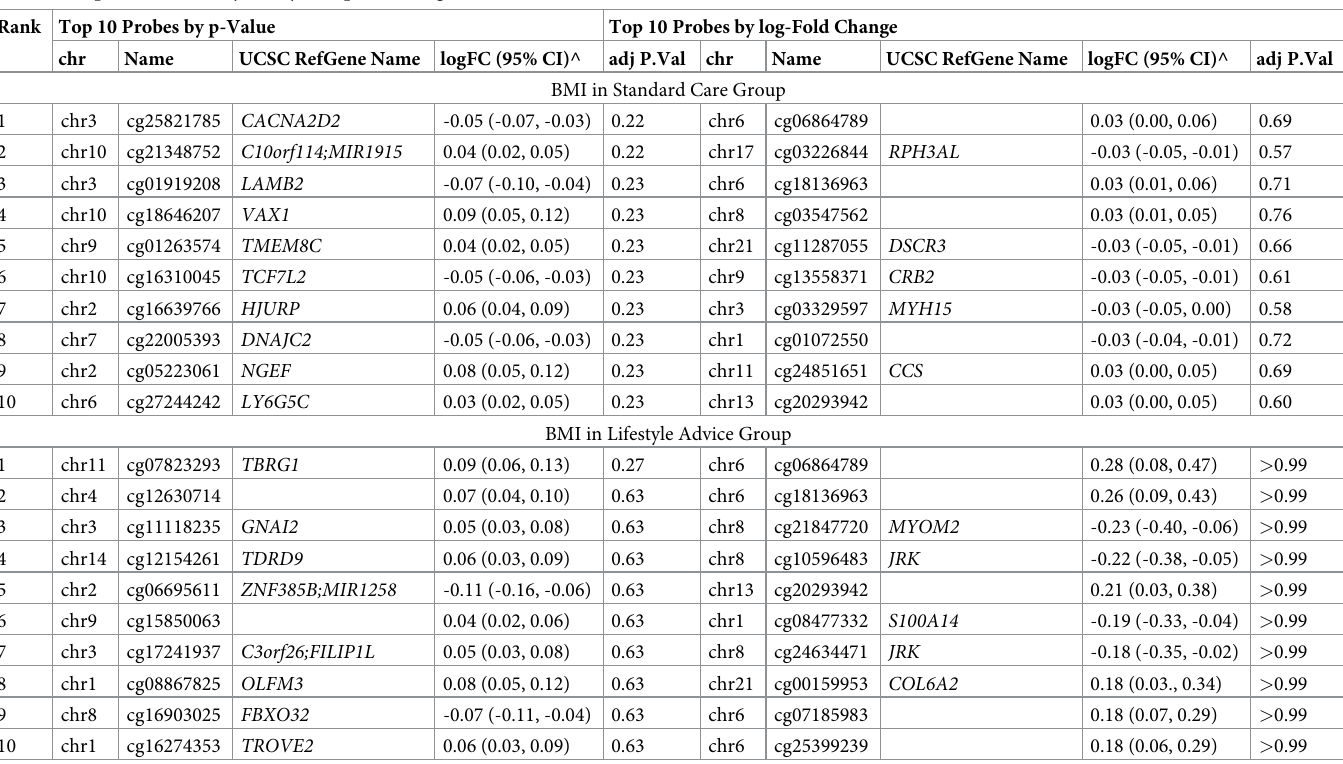
Table 3. Top 10 differentially methylated probes (5 kg/m2 increase in BMI). Rank Top 10 Probes by p-Value Top 10 Probes by log-Fold